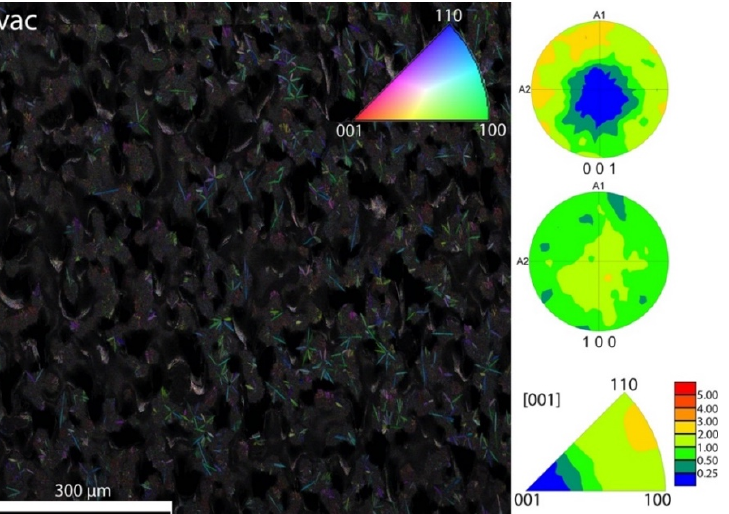
Figure 10. Texture and orientation data of a sample heat-treated in vacuum; 100 and 001 pole figures and [001] inverse pole figure of the texture; 001 inverse pole figure mapping.